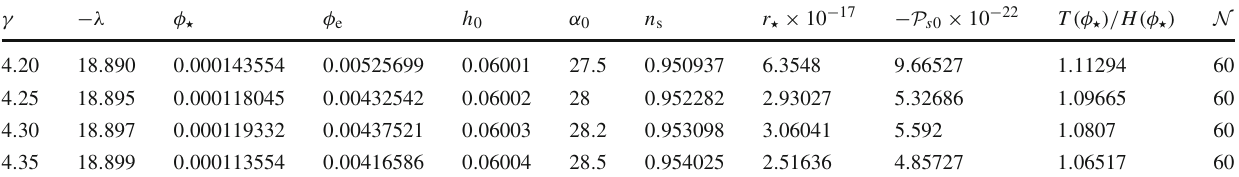
field at the horizon exit. To obtain the presented results we have fixed the power spectrum to its horizon exit value, i.e. P s = 2 . 17 × 10 − 9 , and we have used the numerical values a ζ = 0 . 0185, and b ζ = 2 . 315,